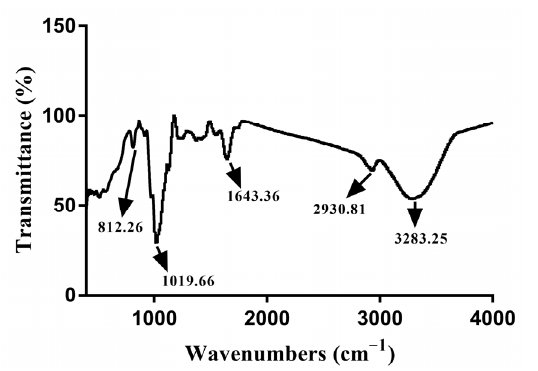
Figure 2. FT-IR spectrum of the EPS from Lpb. plantarum NMGL2 in the range of 4000–400 cm − 1 .